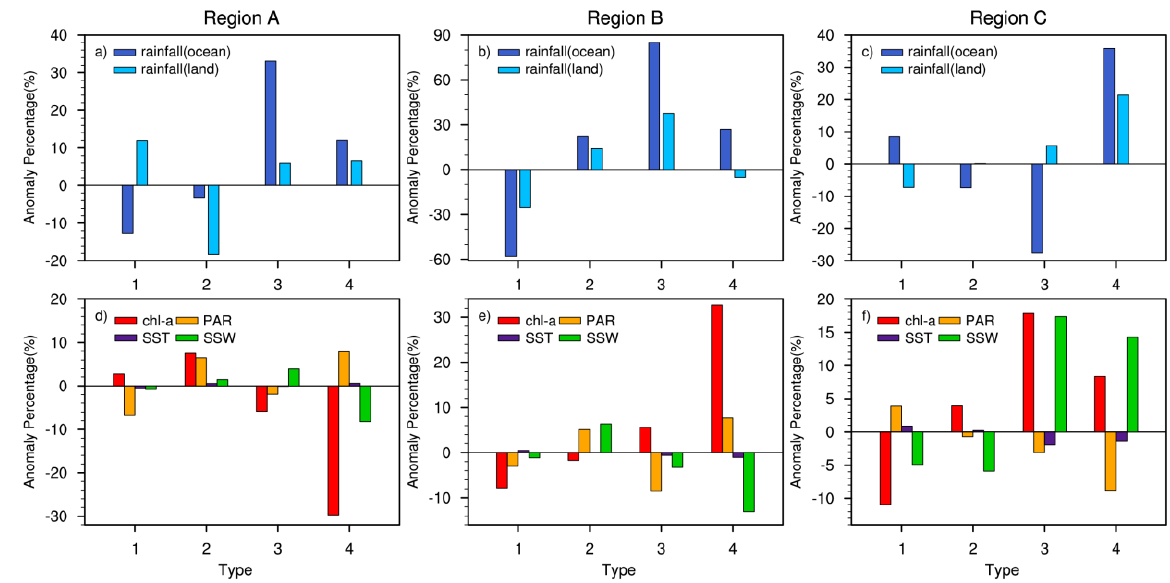
Figure 10. Percentage anomalies of hydrometeorological variables under the four synoptic types in the three regions shown in the black box in Figure 3d (Region A ( a , d ), Region B ( b , e ) and Region C ( c , f )). Table 2. Mean Ekman pumping velocity (×10 − 7 m s −1 ) and mean Ekman transport (m 2 s −1 ) component vertical to the coastline caused by the wind field under the different synoptic types in Regions A and C.